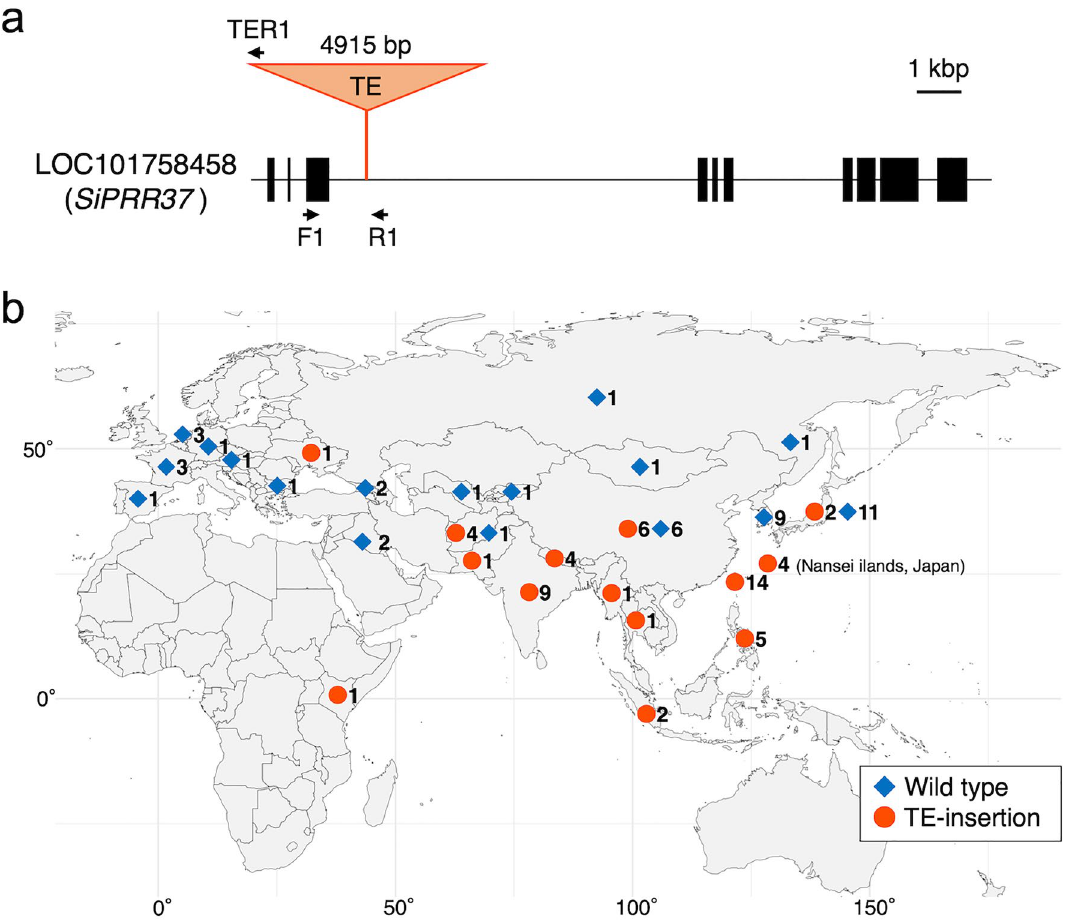
Figure 7. The variant of SiPRR37 with TE-insertion and its geographical distribution. ( a ) Structure of the SiPRR37 gene and insertion of transposable element (TE). Primers used for the analysis of TE-insertion were shown as arrows. ( b ) Geographical distribution of TE-insertion type and non-insertion type (Wild type) of SiPRR37 gene of foxtail millet. The number next to the symbol indicates the number of accessions checked